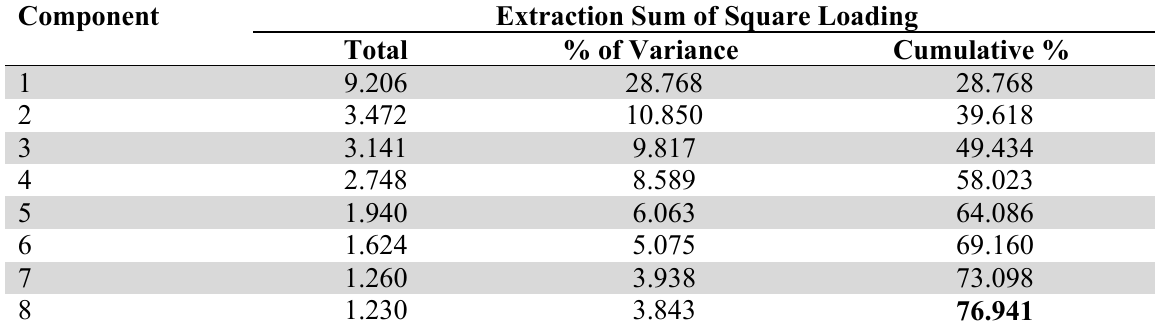
Total variance explained extraction sums of squared loadings Component